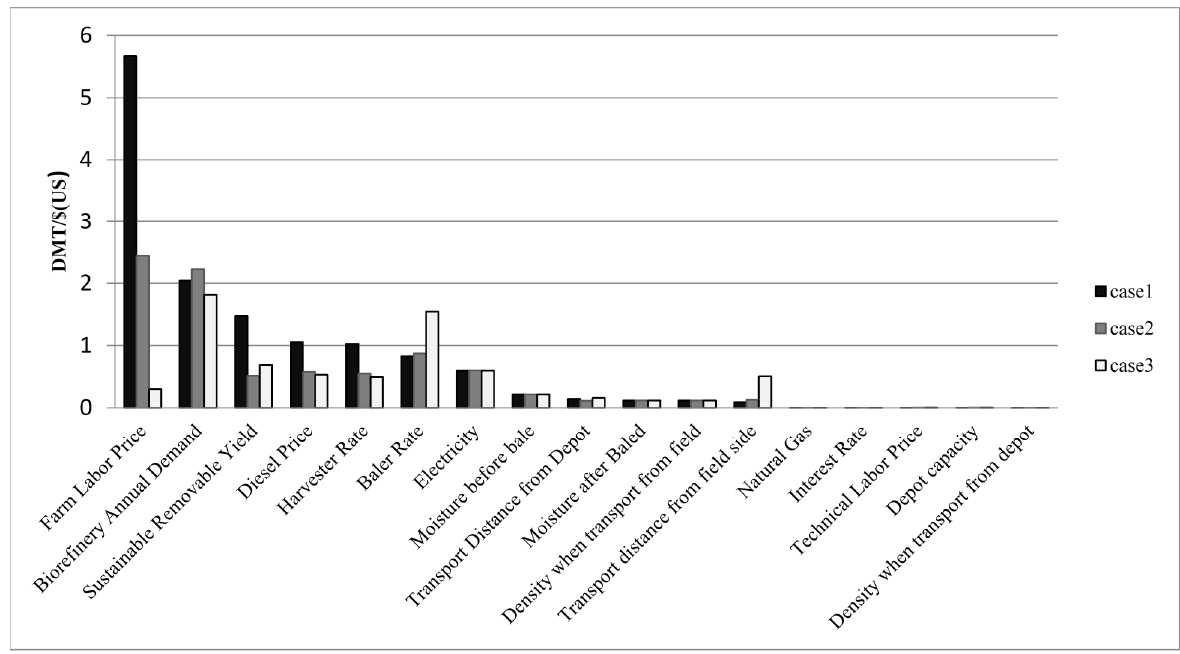
Figure 6. Pareto chart of BLM-Sino FS parameters by associated contribution to total cost for corn stover in northeastern China.